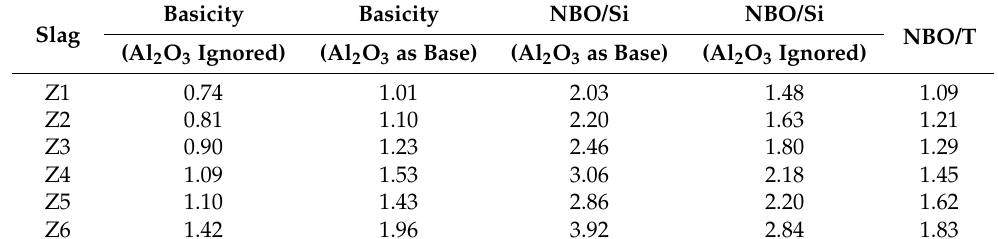
Table 3. Calculated O/Si, NBO/Si, and NBO/T values of different slags (mol).